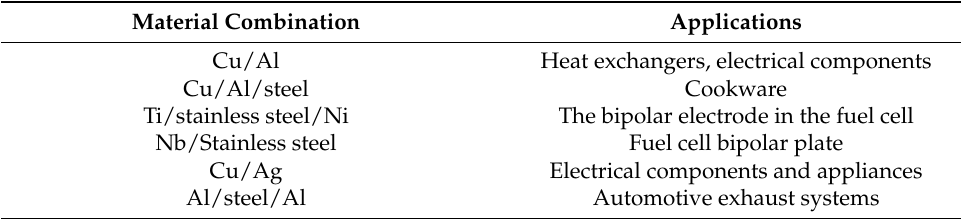
Table 3. Applications of Roll bonding